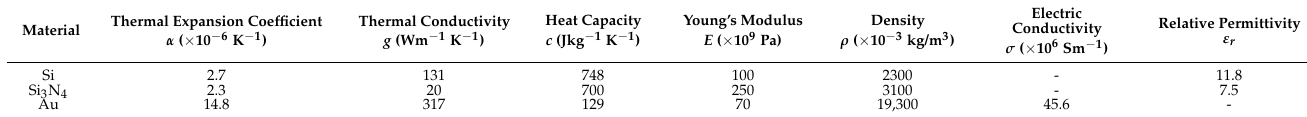
Table 1. Mechanical, thermal and electromagnetic properties of